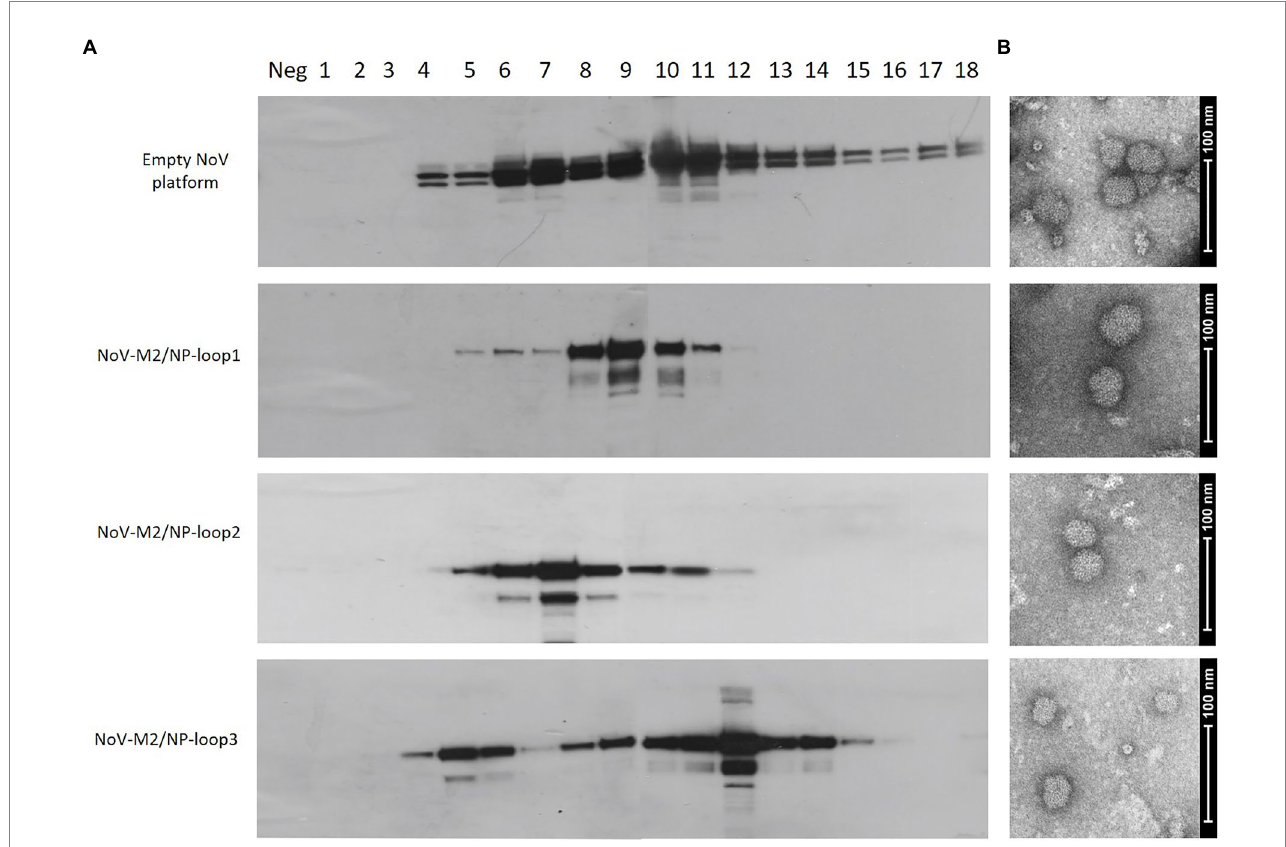
FIGURE 4 Production and purification of genetically engineered calcivirus chimeric VLPs presenting M2/NP epitopes on their surface. SF9 insect cells were infected with recombinant baculoviruses carrying NoV-M2/NP loop 1–3 constructs. Culture media from the aforementioned cells was harvested and purified using a 26%–50% OptiPrep gradient. (A) Western blotting analysis of the sequential fractions collected from ultracentrifugation in OptiPrep gradient. The protein was detected in cell lysates using anti-M2 antibodies. The positive control and reference sample were detected using anti-VP1-NoV antibodies. (B) Electron